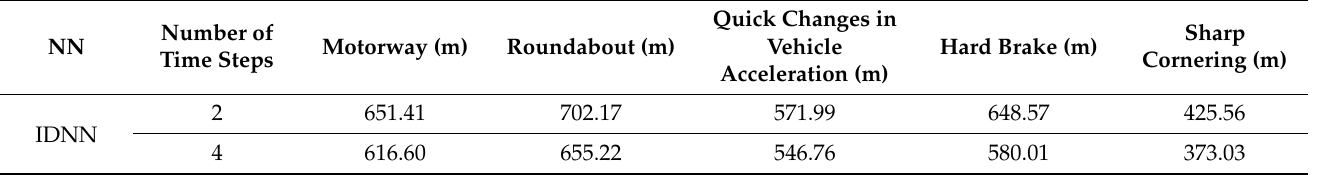
Table 6. Showing the performance evaluation based on the CRSE metric of the IDNN in each investigated scenario across several time steps on the displacement